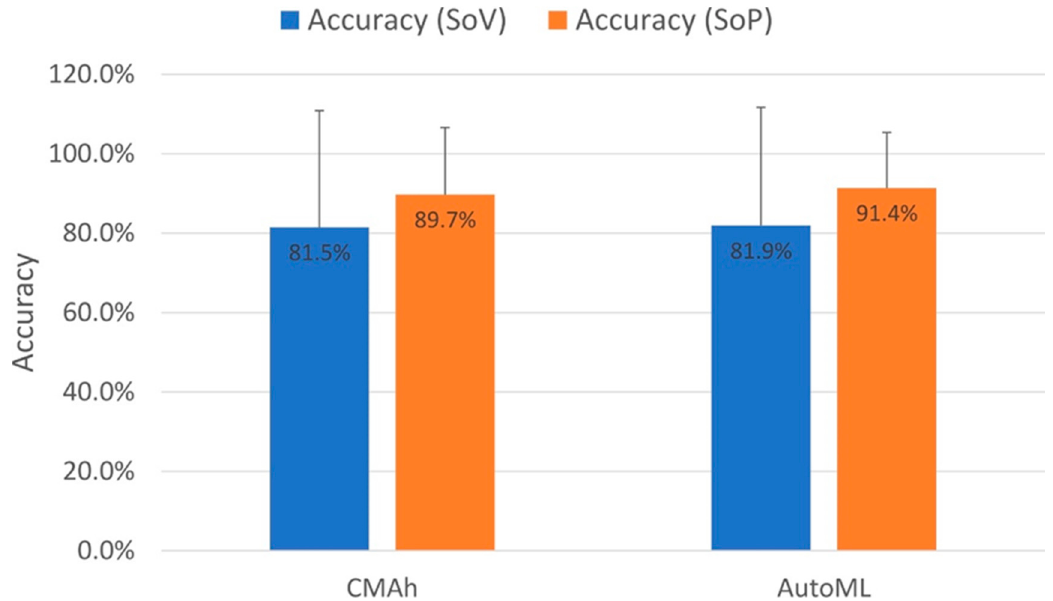
Figure 9. Accuracy of the predicted total number of vehicles over the test period using 2 different approaches (SoV and SoP) for the CMAh and AutoML models (see text for details). Error bars show +1 standard deviation. SoV, the sum of individual vehicle’s predicted binary availability; SoP, the sum of individual vehicle’s probability of availability.